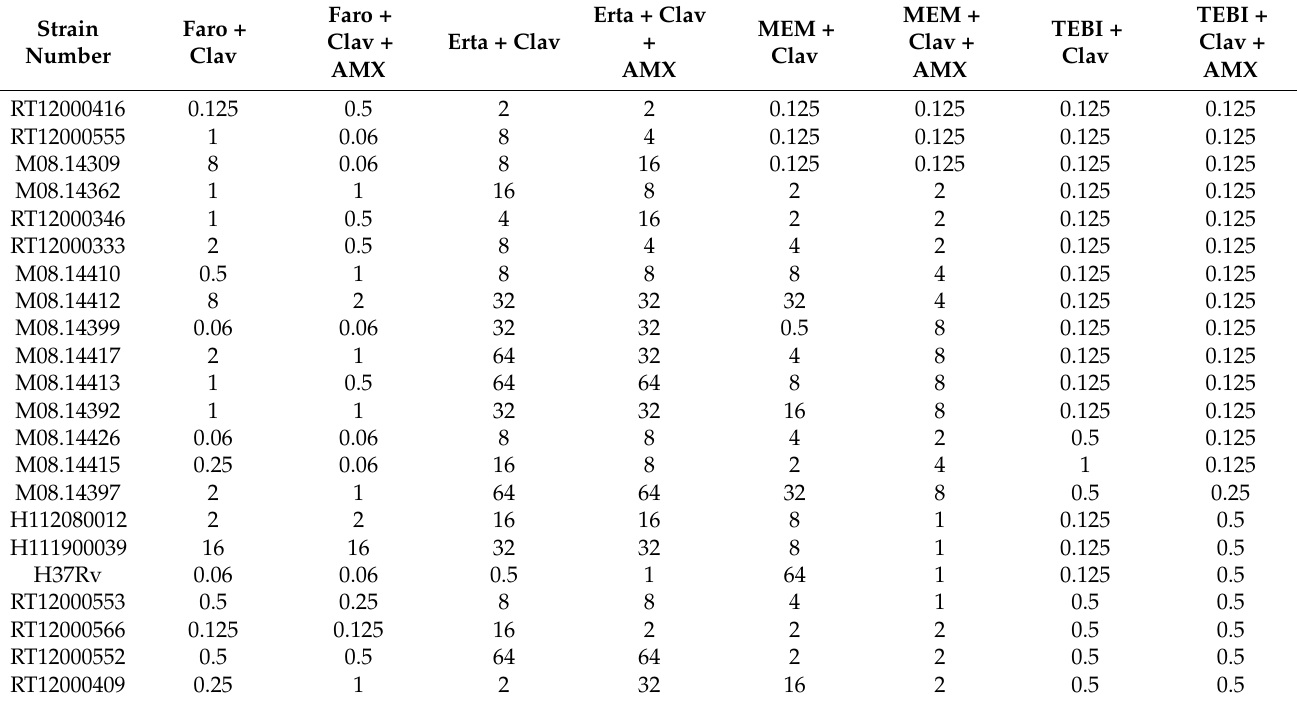
Table 1. MICs of carbapenems (mg/L) in association with clavulanic acid alone as well as clavulanic acid and amoxicillin for fully susceptible MTB strains. Clavulanic acid was used at a fixed